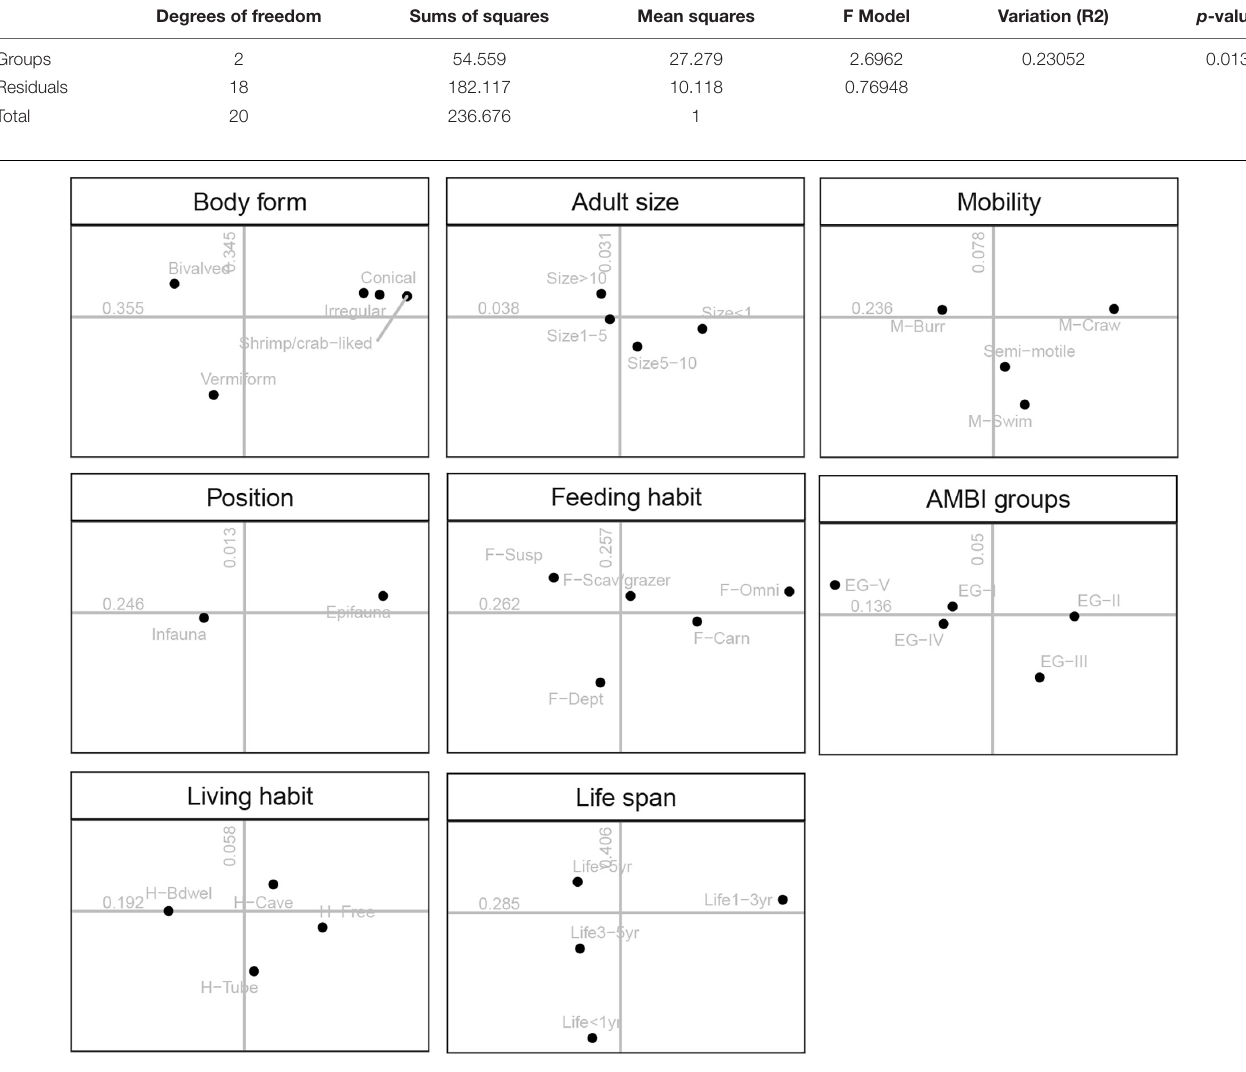
FIGURE 5 | Results of the fuzzy correspondence analysis (FCA): distribution of the 33 modalities of the eight traits on the factor map. Numbers indicated the correlation ratio with axis 1 (horizontal) and axis 2 (vertical). For full labels of trait modalities, see Table 1 .